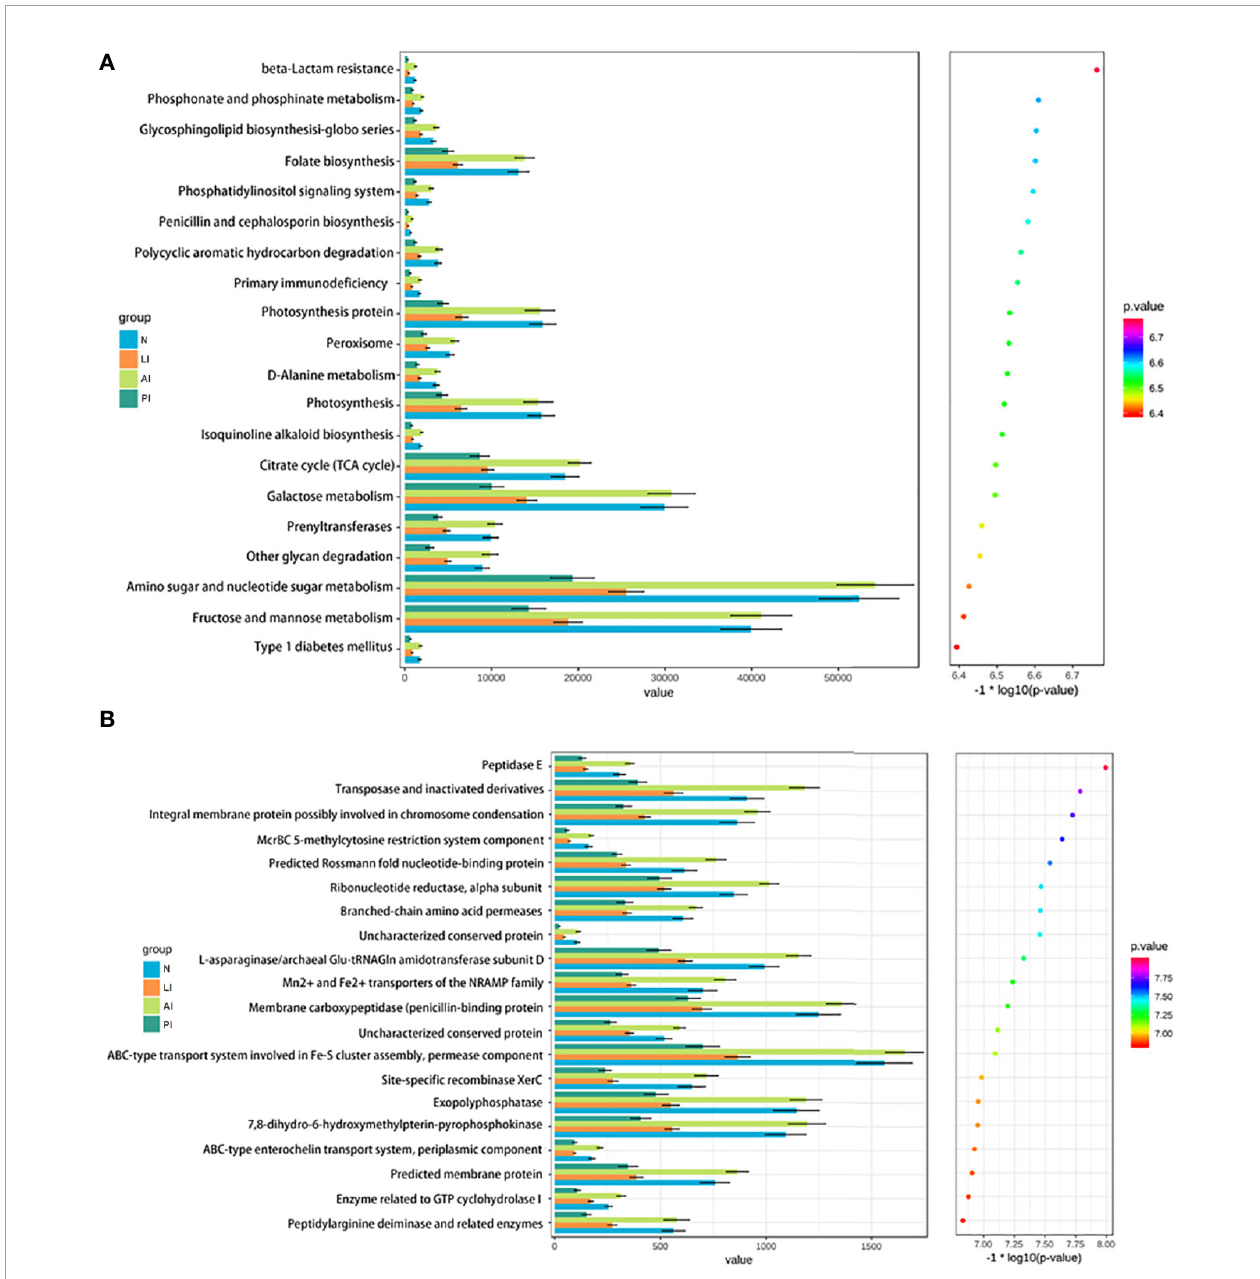
FIGURE 6 | KEGG pathways (A) and COG categories (B) that was less frequent in stroke groups than healthy